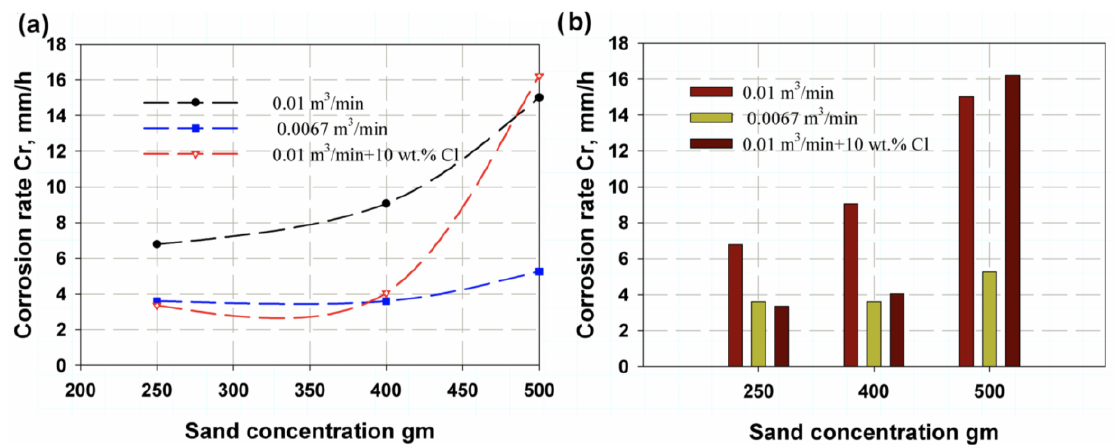
Figure 6. Corrosion rate variation with abrasive sand amount: ( a ) total trend, ( b ) maximum value.